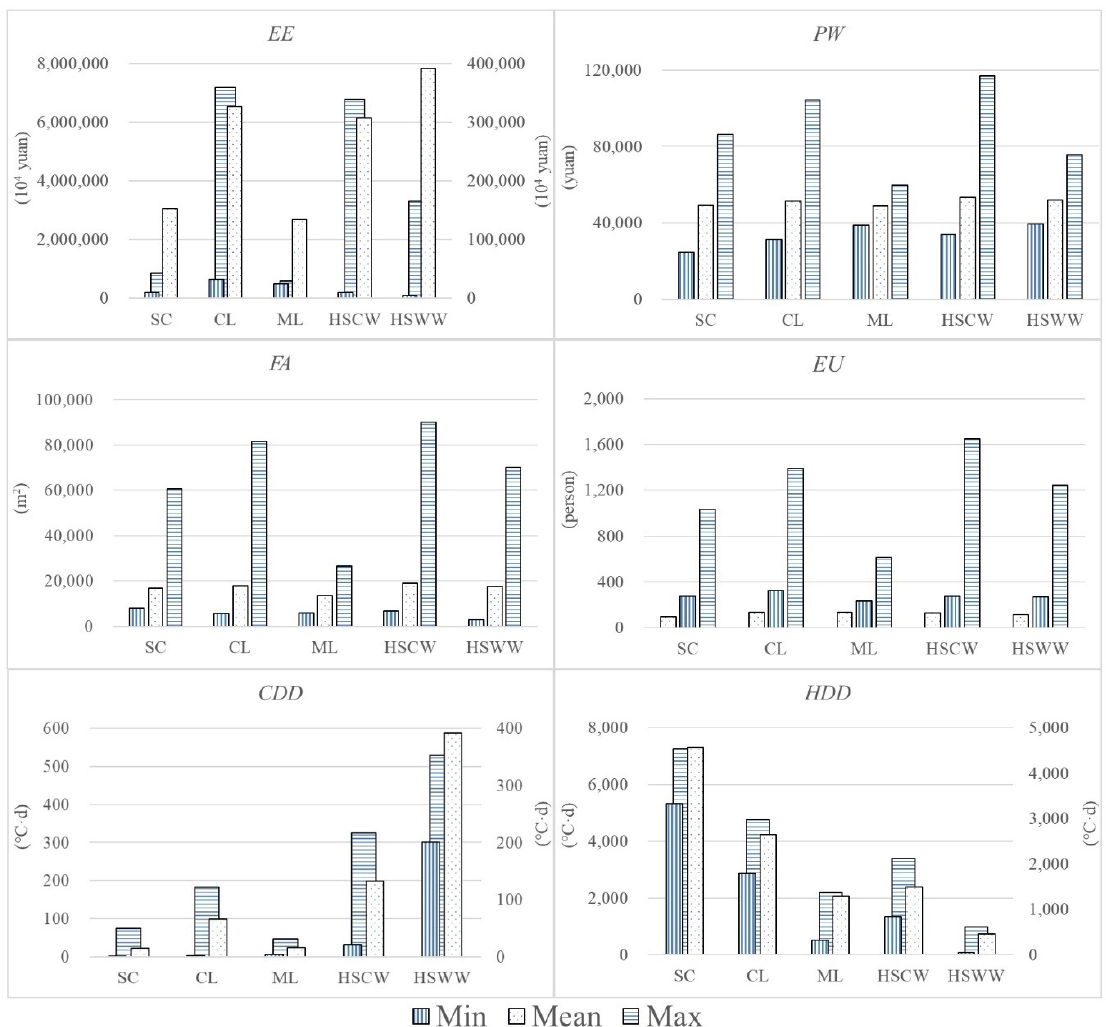
Figure 7. Minimum, mean, and maximum values of independent variables in each zone. Among them, the minimum and mean values of EE, CDD, and HDD are shown through the secondary ordinate axis on the right.